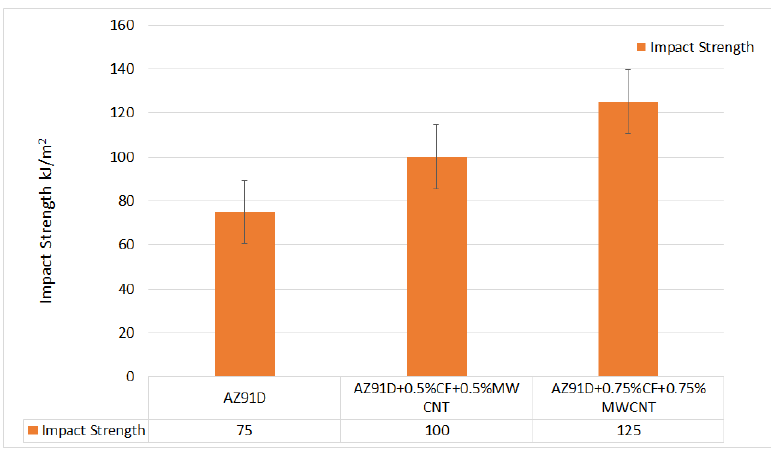
Figure 7. Variation of impact strength of Mg AZ91D hybrid composite with varying weight percent- ages of CF and MWCNT